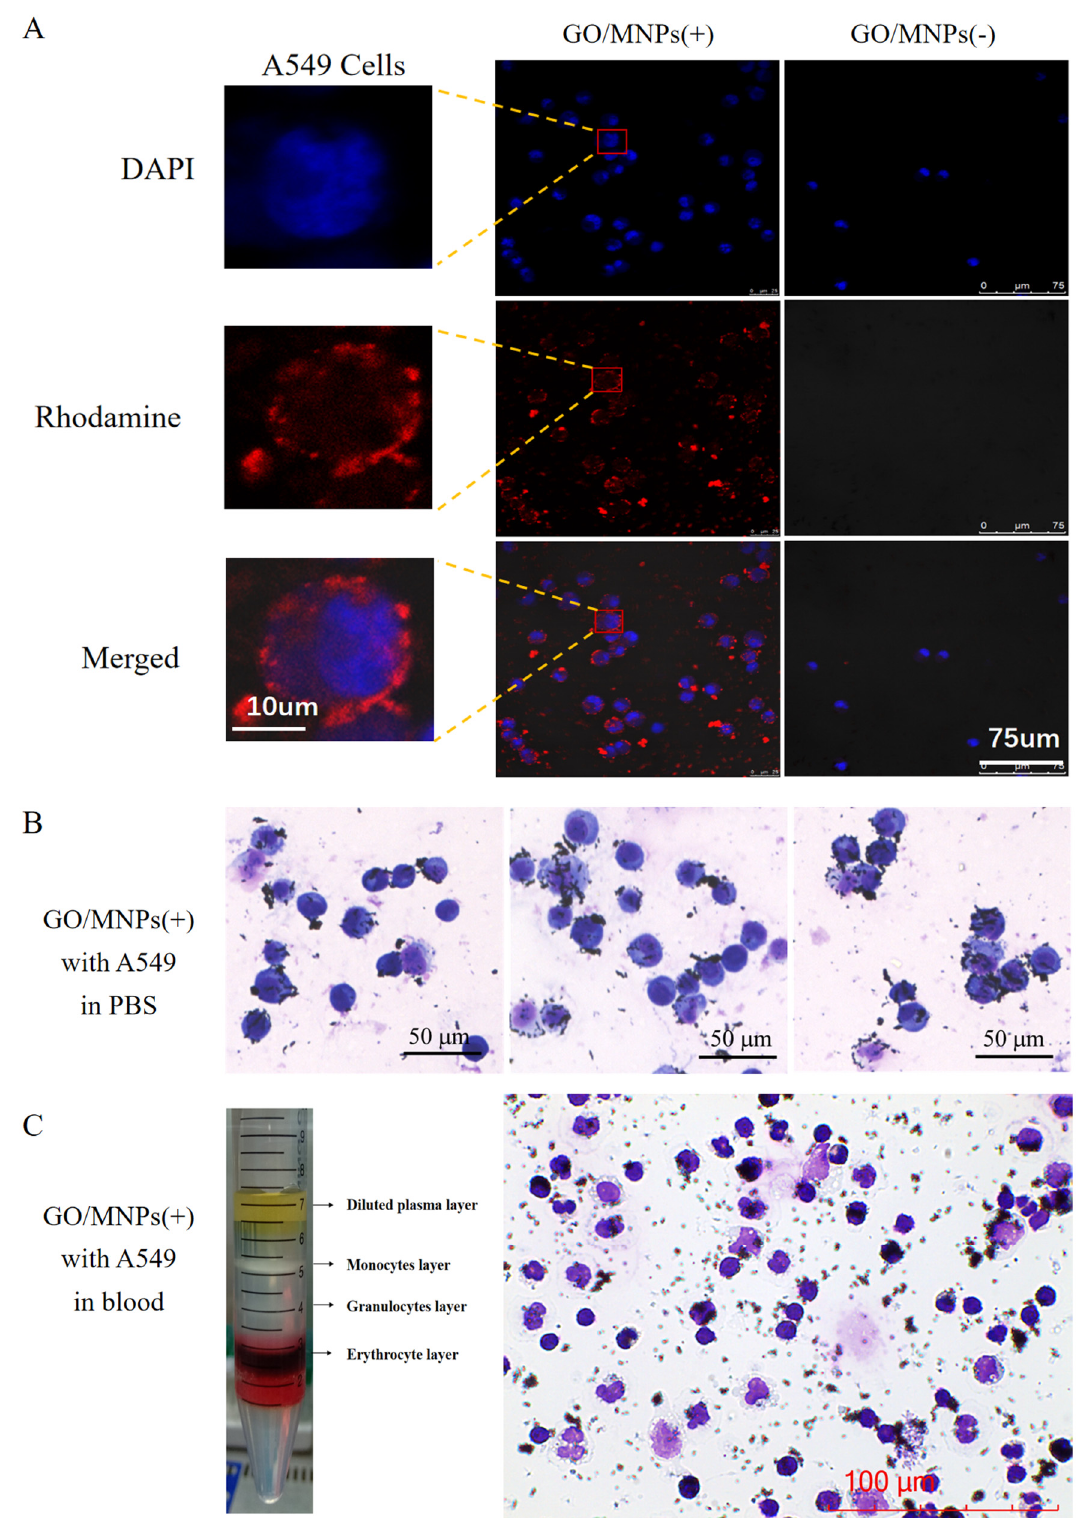
Figure 3. Monitoring the electrophysiological characteristic of cancer cells using charged nanoprobes. ( A ) A549 cells binding status to GO/MNPs(+) and GO/MNPs(-). The microscopic observation of the specific targeting of GO/MNPs(+) to A549 cells in ( B ) PBS or ( C ) simulated blood samples (cancer cells spiked into healthy blood samples), and the digital picture of different cell types in blood samples can be separated by gradient centrifugation for pretreatment.